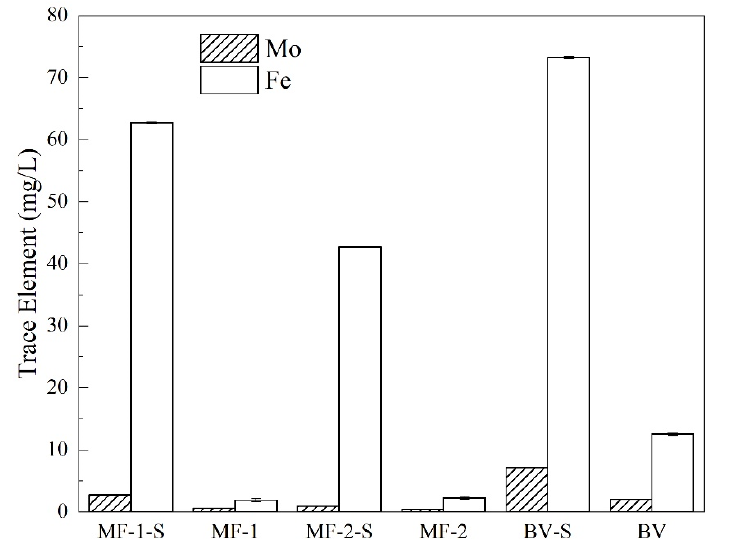
Figure 3. Trace elements’ concentration (Mo and Fe) in Groups MF-1, MF-1-S, MF-2, MF-2-S, BV and BV-S.